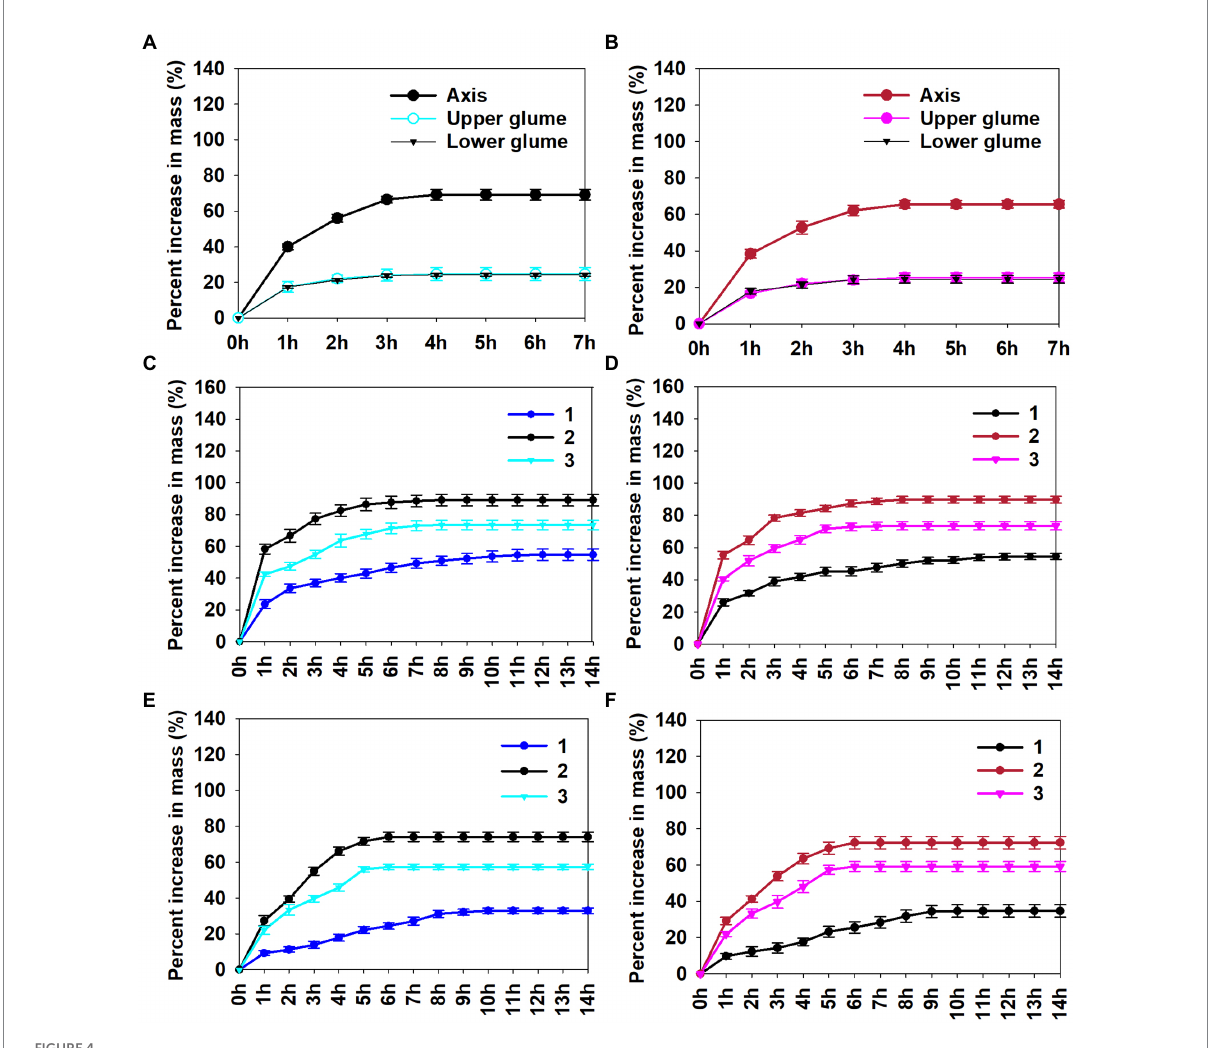
FIGURE 4 Cumulative percent increase in mass via imbibition of water by three associated structures (A, B) , seeds with (C, D) and without (E, F) lemmas and paleae of Left (A, C, E) and Right (B, D, F) spikelet types in Aegilops tauschii . Numbers 1, 2 and 3 following abbreviations indicate different seed